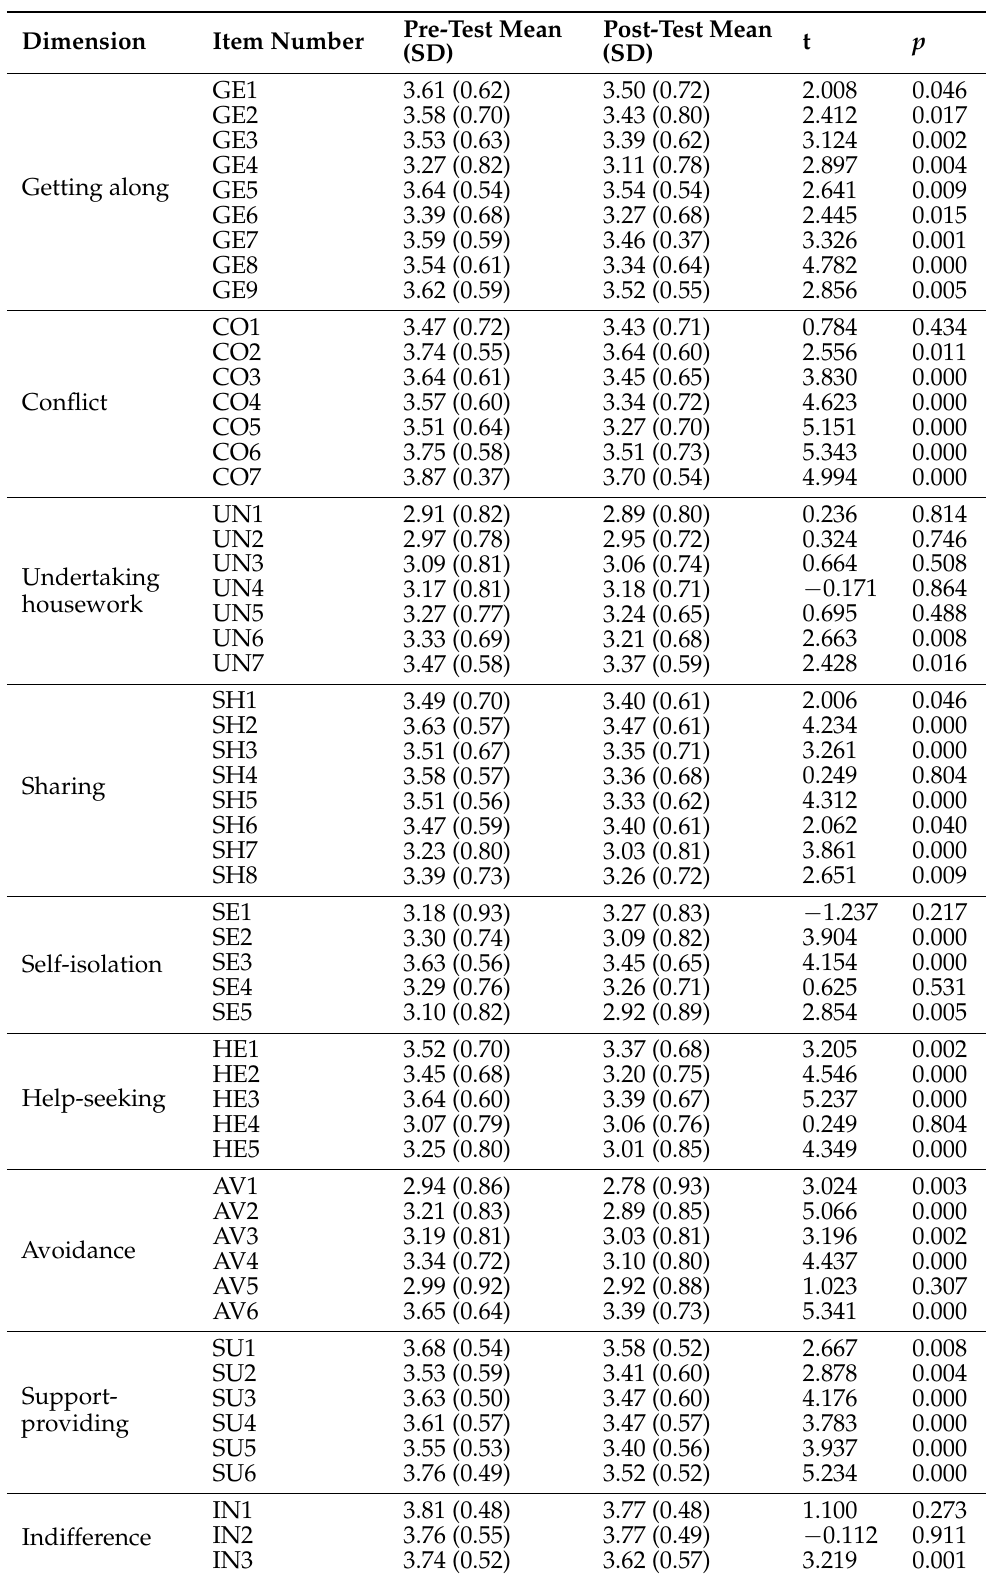
Table 5. The results of paired sample t -tests on 56 items of the CSEFHQ. Dimension Item Number